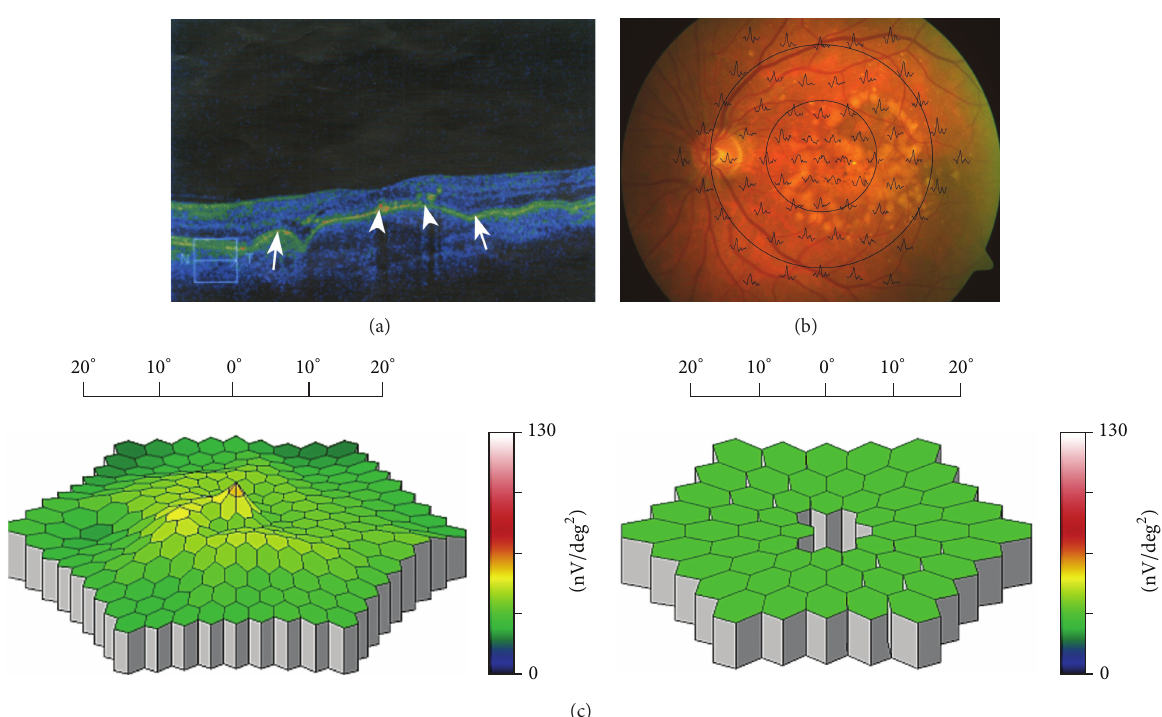
Figure 2: (a) SD-OCT of the left eye of a patient with the dry form of AMD before initiation of rheohemapheresis treatment. A large photoreceptor IS/OS junction defect marked by arrows at its beginning and end. Only the top of the surface DPED under the central foveola shows remnants of previous photoreceptor IS/OS junction detachment (indicated by arrowheads) in the form of degraded degenerated material of the original junction. The photoreceptor IS/OS junction is normally attached to the RPE only peripherally from the arrows. Visual acuity at this stage was 20/80 (0.25). (b) Multifocal electroretinography. Superposition of mfERG responses to the fundus of the left eye of the patient from (a). (c) A three-dimensional image of the electrical activity of the retina. Left: A three-dimensional image of the electrical activity of the retina of the left eye of the patient from (a) and (b) compared to the normal-for-age image on the right (decrease of foveal and parafoveal responses below the normal range, i.e., grey-colored central depressions bordered by green, i.e., within normal range